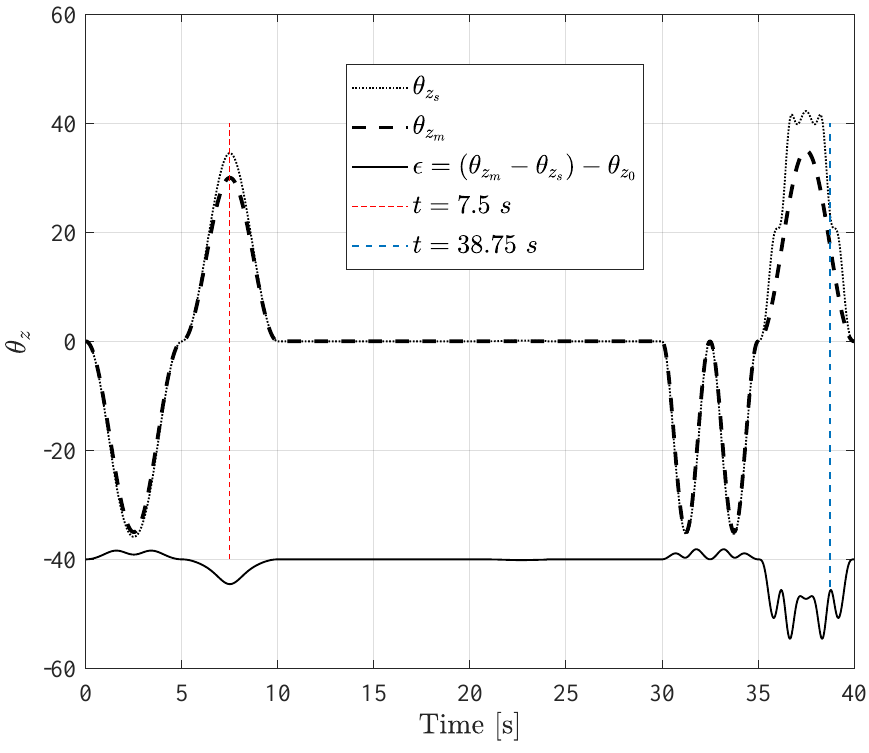
Figure 8. Master to slave R z